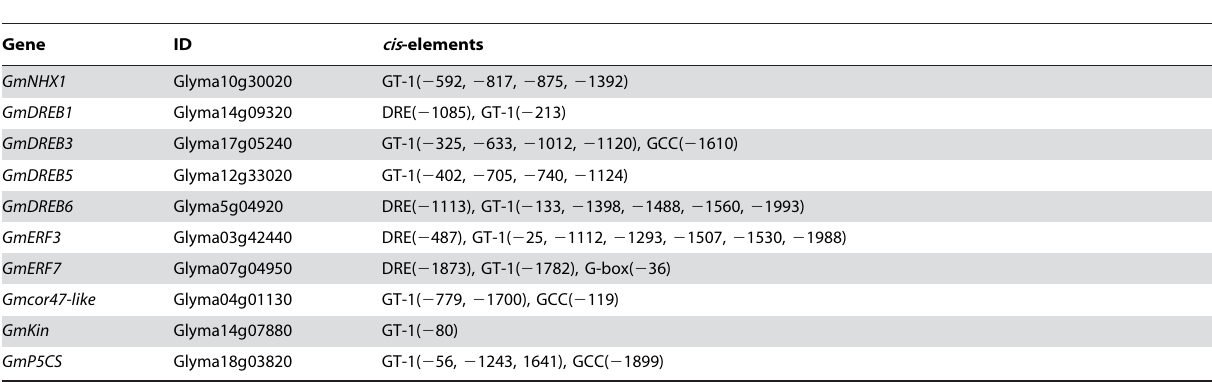
Table 2. cis -elements in promoters of OsDREB2A-activated genes.